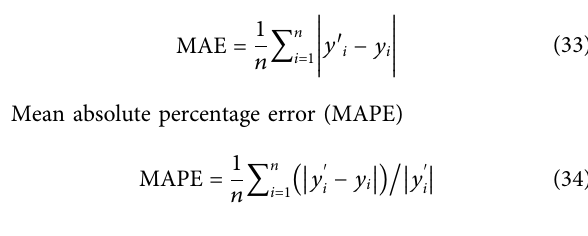
Frontiers in Built Environment |